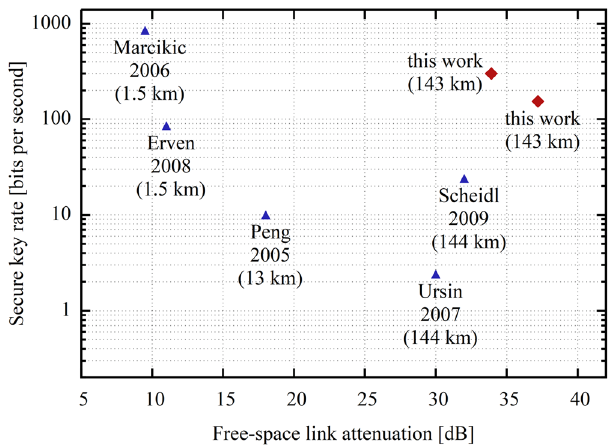
Fig. 1 Comparison of secure key rates. Only published QKD fi eld trials over a free-space link employing polarization-entangled photon pairs are compared. The horizontal axis corresponds to the attenuation caused by the free-space link and the receiver optics. Each blue data point represents a published experiment: Peng 2005 (ref. 36 ), Marcikic 2006 (ref. 34 ), Ursin 2007 (ref. 14 ), Erven 2008 (ref. 35 ), Scheidl 2009 (ref. 37 ); the red data points represent the two highest key rates achieved in this work. Apart from ref. 35 and ref. 36 , all experiments employ a single free-space